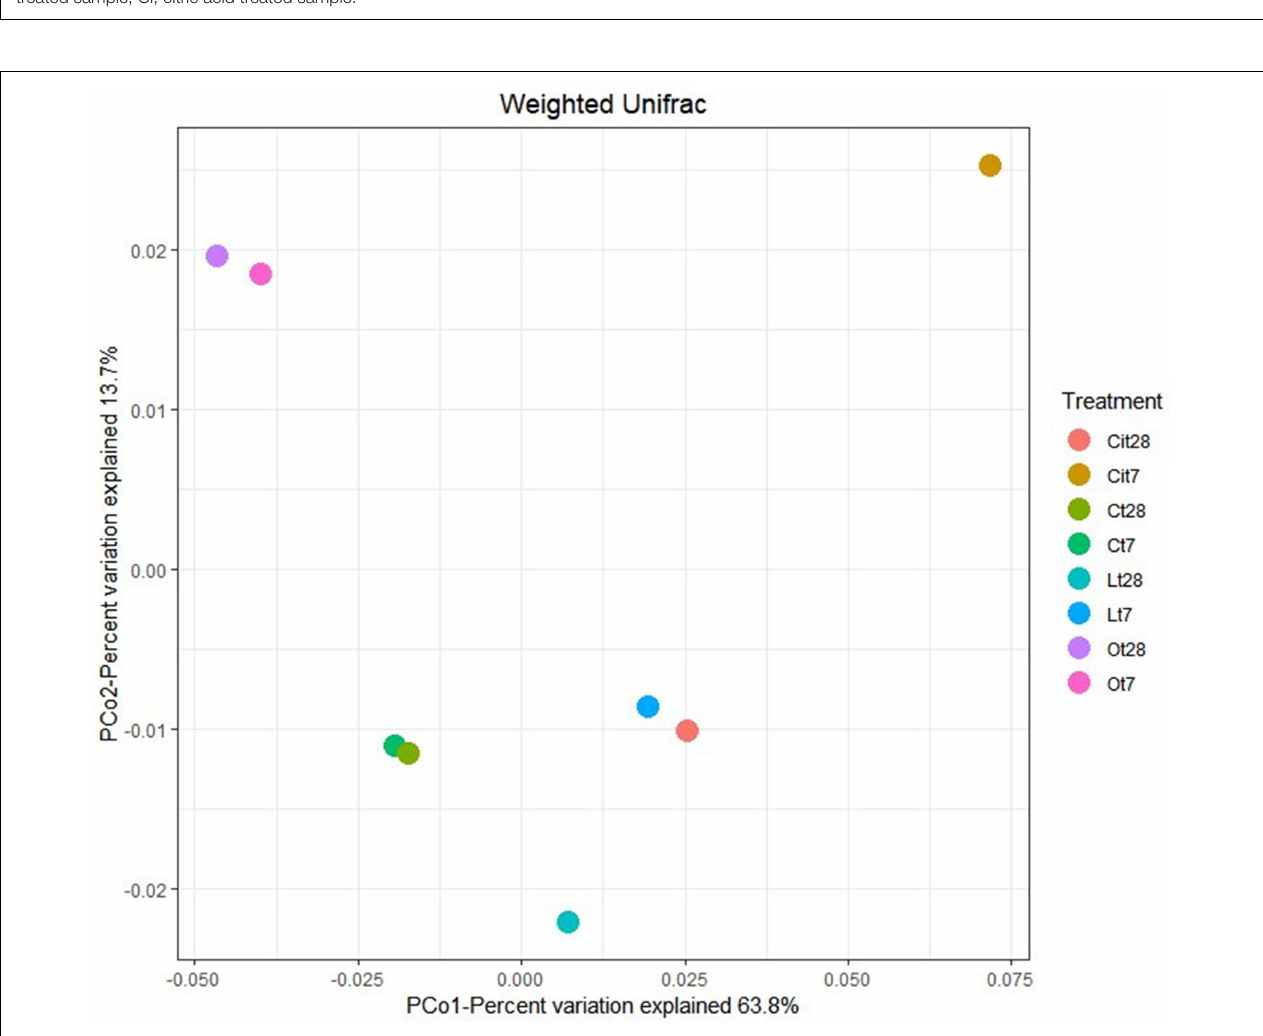
FIGURE 6 | Principal coordinate analysis (PCoA) based on the Weighted Unifrac distance. C, control sample; L, lactic acid treated sample; O, oxalic acid treated sample; Ci, citric acid treated sample. t7: day 7; t8: day 28.